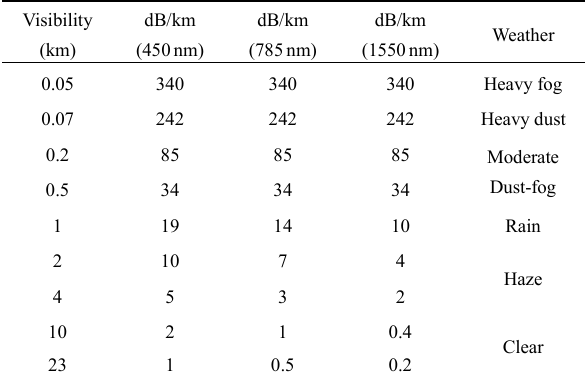
Table 1 FSO link attenuation in dB/km according to the Kim model.